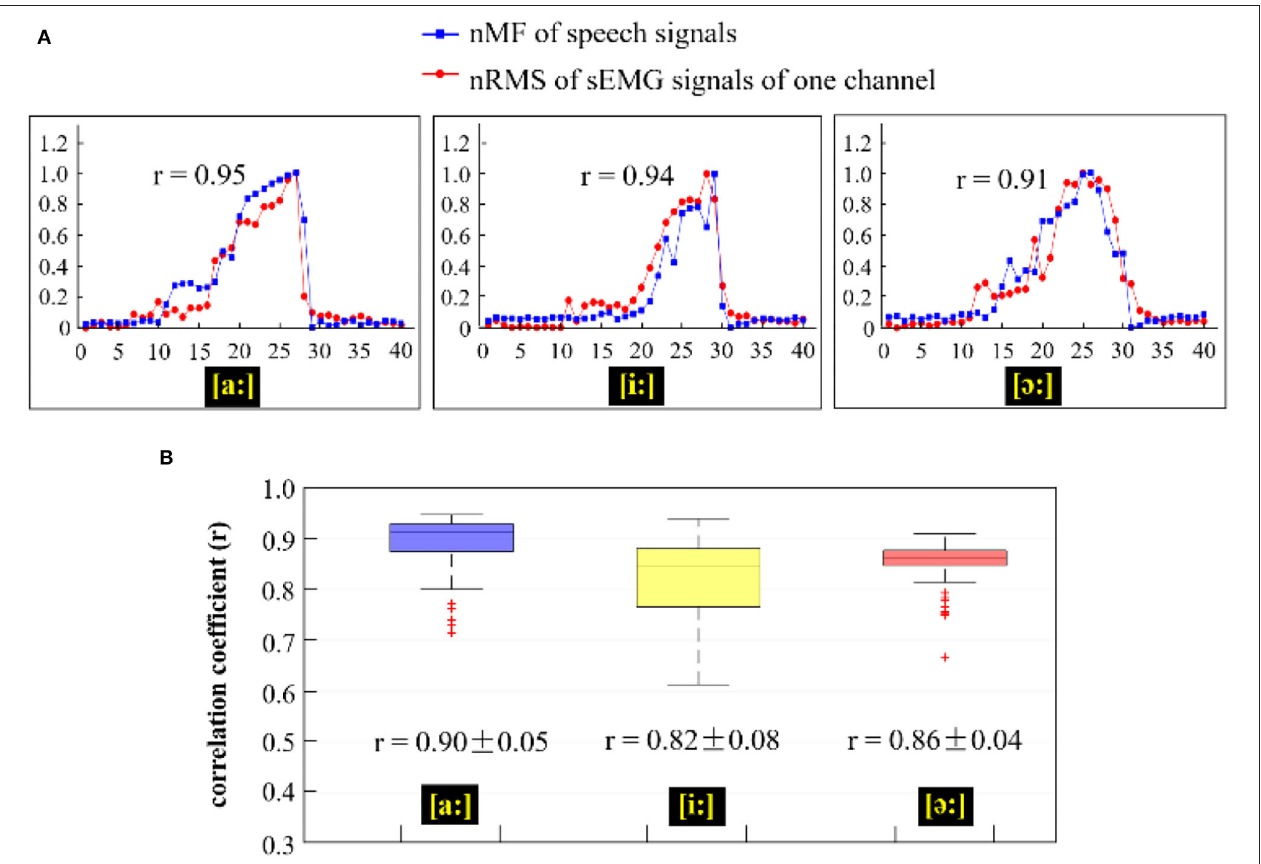
FIGURE 9 | (A) Comparison of the nMF of the speech signals and the nRMS of the sEMG recordings from channel E8 when phonating three different vowels [(a:), (i:), and ( e:)] with increasing pitch; (B) Correlation coefficients between the nRMS values of 120 channels of sEMG recordings and the nMF of the speech signal across three different vowels [(a:), (i:), and ( e :)].